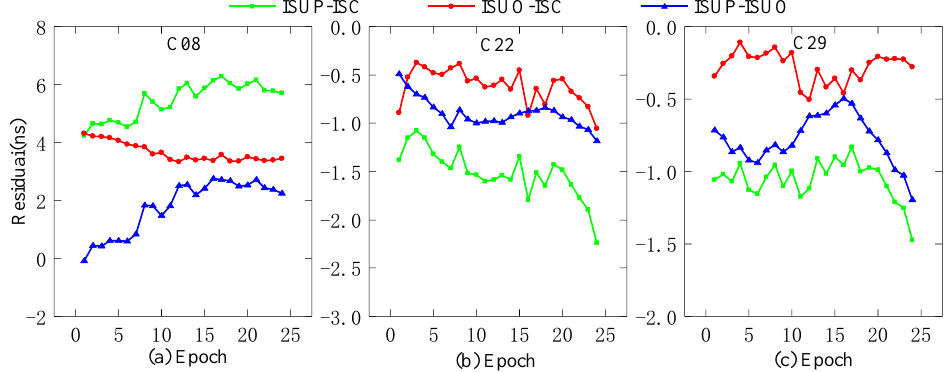
Figure 3. The residual plot of the RB clock as a reference clock. ( a ) The residual value of C08 pre- dicted after 6 h. ( b ) The residual value of C22 predicted after 6 h. ( c ) The residual value of C29 predicted after 6 h.